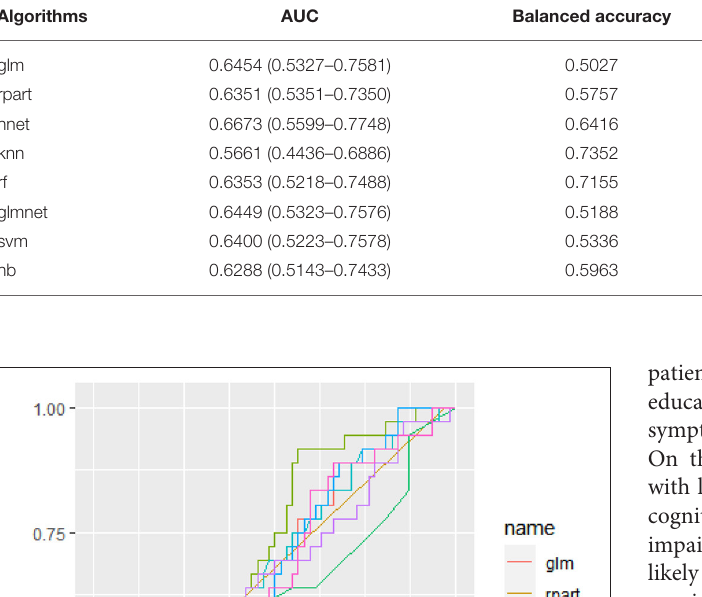
TABLE 4 | Prediction ability of ML algorithms in testing set.